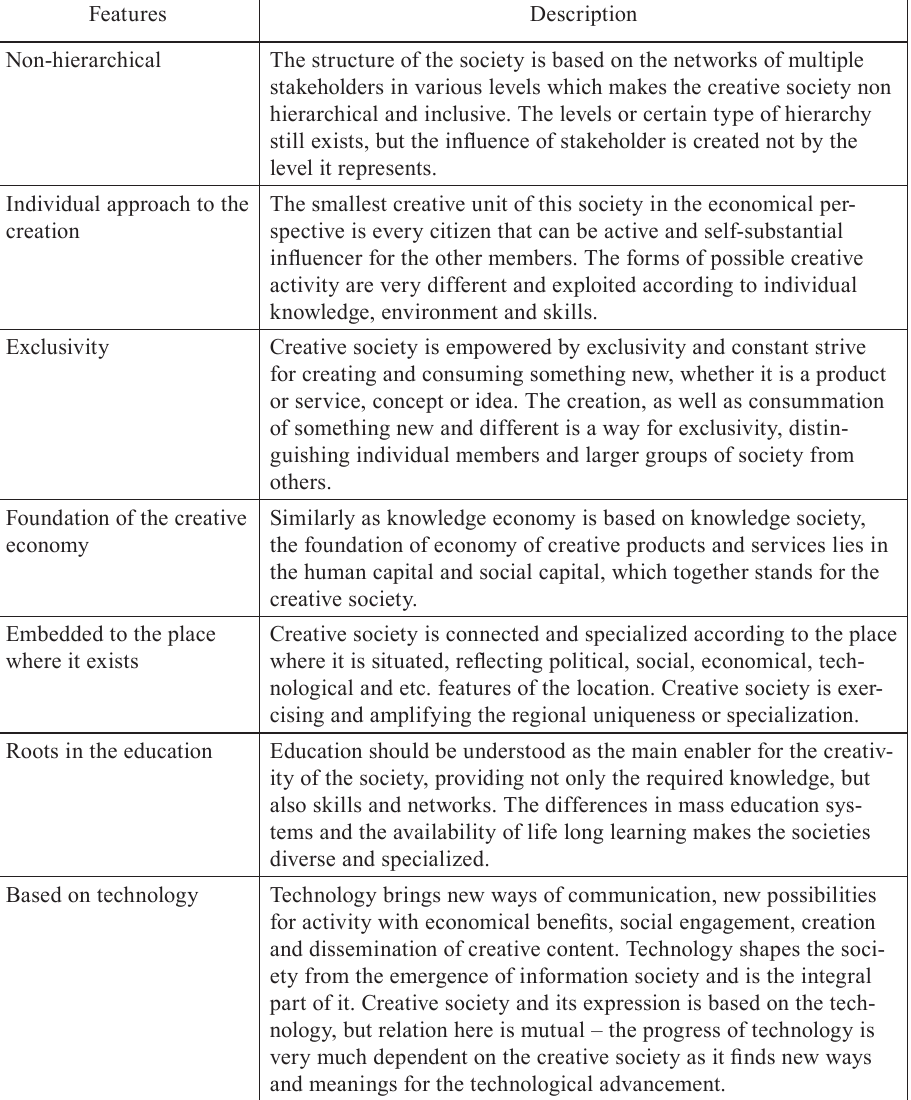
table 1. Features of the creative